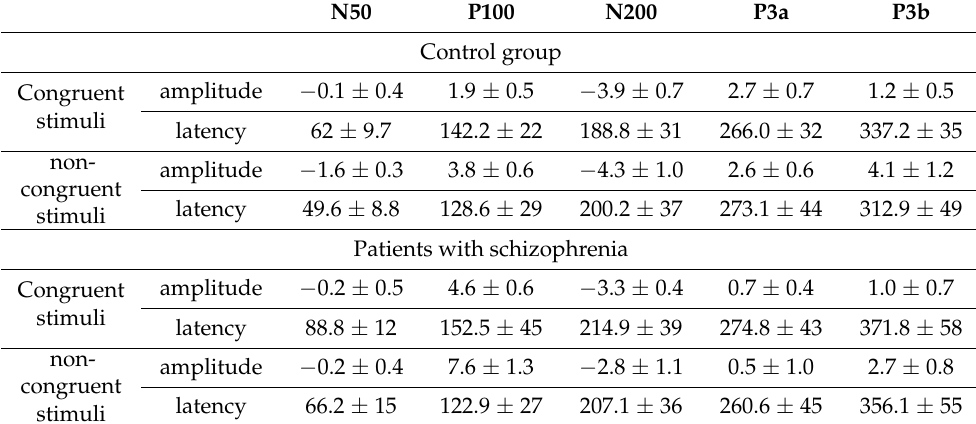
Table 1. The amplitudes and latencies of each ERP component for congruent and non-congruent stimuli and for each group of subjects (patients and